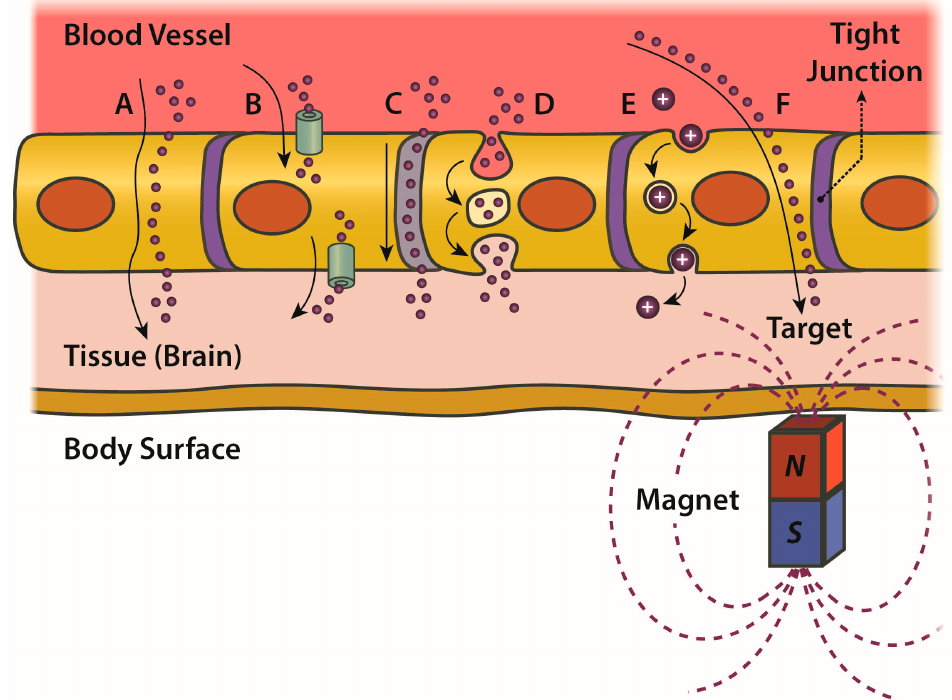
Figure 3. Schematic enumeration of the many pathways which a compound can use to cross the blood-brain barrier, depending on its chemico-physical properties. ( A ) Drugs can cross the barrier simply by passive diffusion if they are sufficiently lipid soluble (or have been made lipophilic by appropriate chemical modifications); ( B ) Carrier protein-Mediated active Transport (CMT) can allow many essential compounds such as glucose and amino acids to enter the endothelial cytoplasm and then be released into the brain at the abluminal side. In addition, artificial compounds mimicking those endogenous ligands have been developed to take advantage of the carrier-mediated transport mechanisms; ( C ) Drugs or even NPs can enter the brain through a paracellular route only when the tight junction system is disrupted. In particular, BBB permeability can be temporarily induced in several ways: by local temperature increases (38–39 °C), by osmotic alterations (e.g., infusion of hypertonic solutions of mannitol), by adenosine receptor activation, by Focused Ultrasound (FUS) bombardment or by electromagnetic radiations; ( D ) The binding of specific ligands to the receptors mediating the endocytosis (e.g., transferrin and insulin receptors) allows the uptake of large compounds and NPs conveniently functionalized. By a subsequent exocytosis process, vesicles can then release their content at the abluminal side (RMT); ( E ) If the compound has sufficient cationic charge, it can induce a localized electrostatic disruption of membrane phospholipids resulting in the so-called Adsorptive-Mediated Transcytosis (AMT); ( F ) If the drug is carried by NPs exhibiting magnetic properties (such as IONs) a localized magnetic field, generated by an external electromagnet, can be used to produce a driving force enabling the passage of such NPs from the bloodstream to a targeted region of the brain (through both paracellular and transcellular routes).